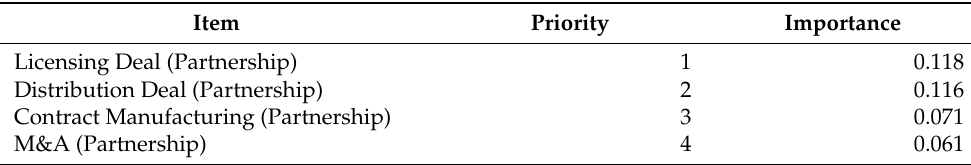
Table 9. Results of partnership type.